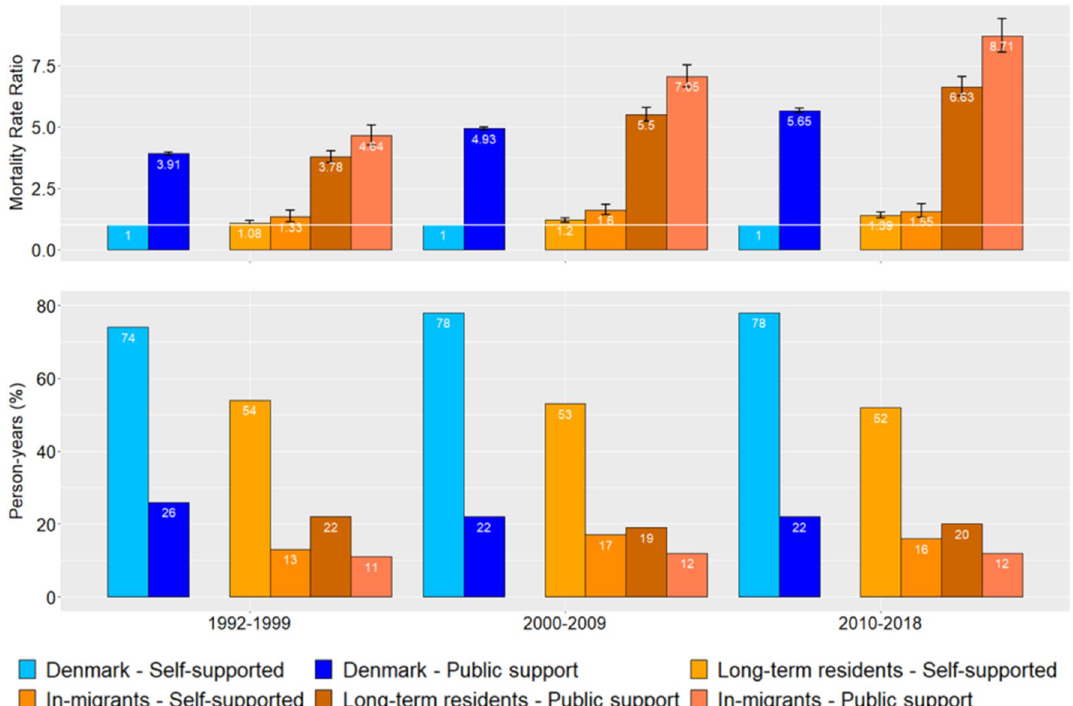
Figure 2. Mortality rate ratio and percentage of person-years for the rest of Denmark and the total population aged 30–64 years in Lolland-Falster by residency group, economic status, and time-period. Adjusted for 5-year age-groups and sex. Reference population = Self-supported in rest of